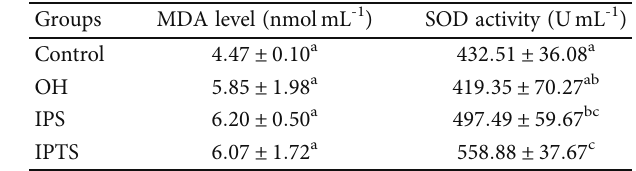
Control: control rats with standard feed, OH: OVx rats with standard feed, IPS: OVx rats with instant pumpkin cream soup feed, and IPTS: OVx rats with instant pumpkin cream soup enriched with tempeh. Values are the mean ± standarddeviation (SD) of the three replicates. Di ff erent letters in the same column indicate signi fi cant di ff erences ( p > 0 : 05 ) between